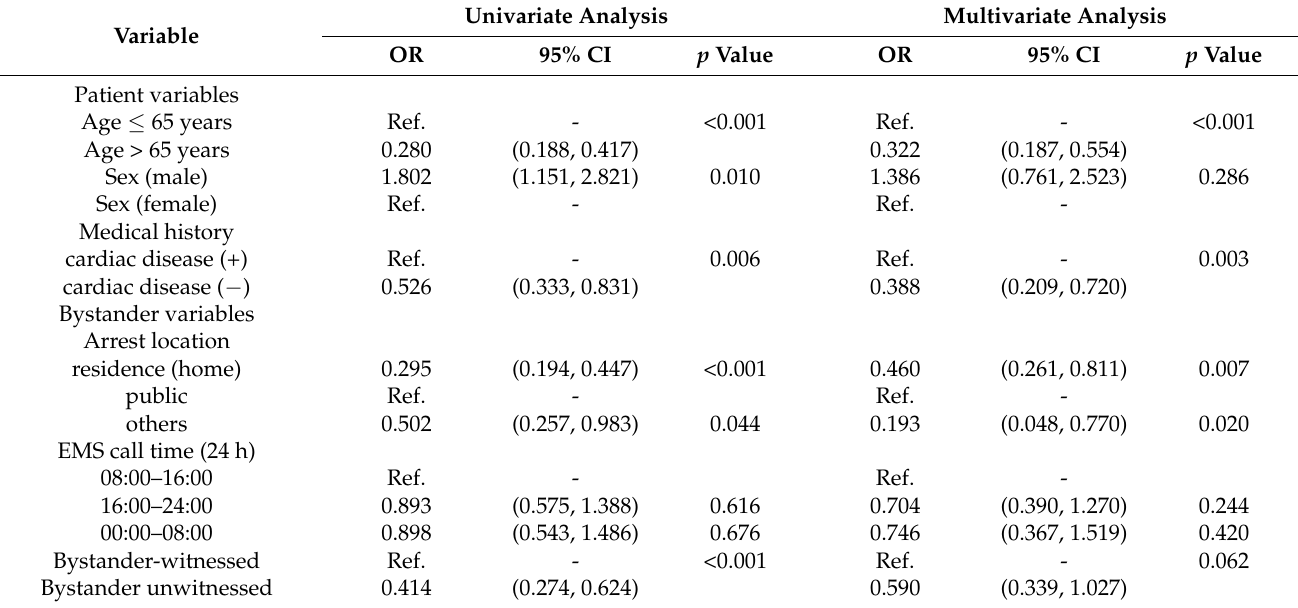
Table 4. Factors associated with survival to discharge after OHCA in the urban